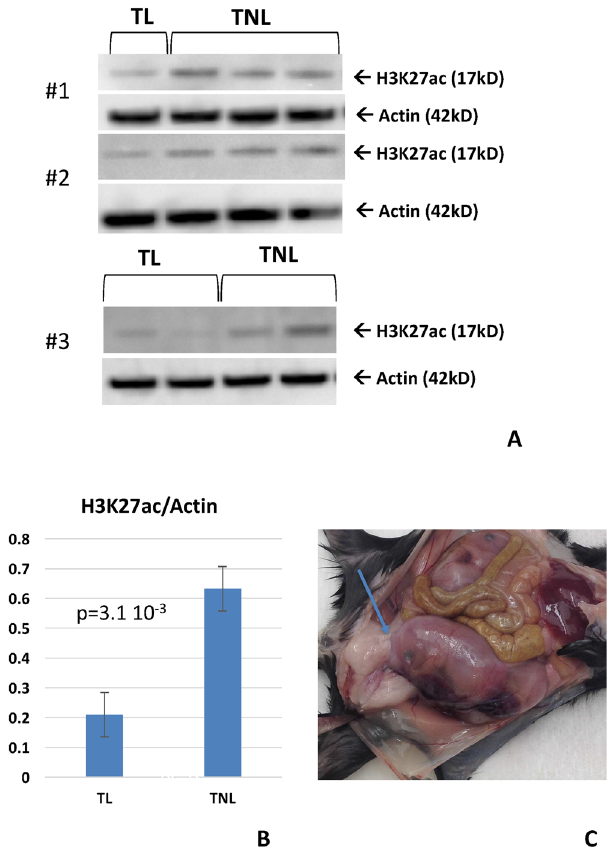
Figure 6. Degree of histone acetylation (H3K27ac) in the mouse cervix. ( A ) Western blots for H3K27ac, and actin at day 18 TNL (term not in labor), and 18 TL (term in labor). This panel summarizes three experiments, #1, #2, and #3. In experiments #1 and #2 each one mouse was anatomically diagnosed as in labor (TL), but before extrusion (see C for example), and experiment #3 had two animals TL. ( B ) Relative quantification of western blotting signal, H3K27ac/actin, for E18TNL and E18TL samples. Note the lower degree of histone acetylation of samples taken from animals in labor compared to term but not in labor samples. ( C )